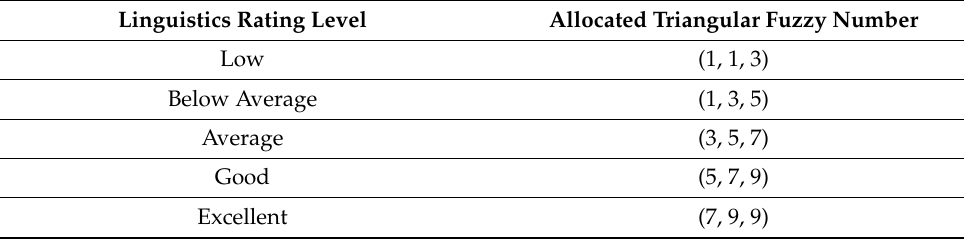
Table 4. Phonology grade level substitutes.